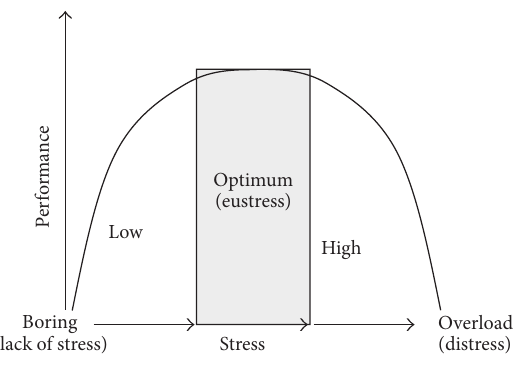
Figure 1: Stress in the body: an optimal level of stress (called eustress) is required for the best performance. Not only too much, but also too little stimuli are harmful.